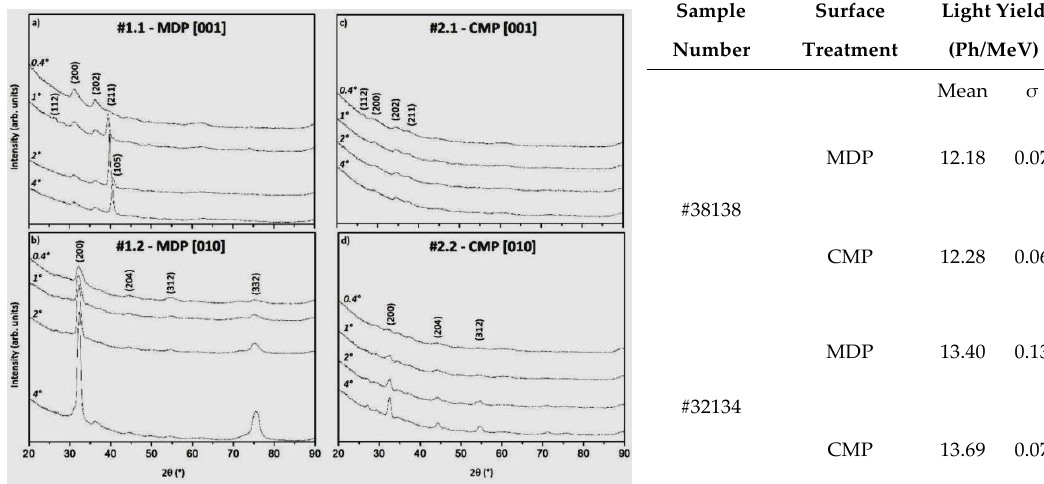
average values (AV) and standard deviations (SD). XRD analysis and conoscopy are in agreement on